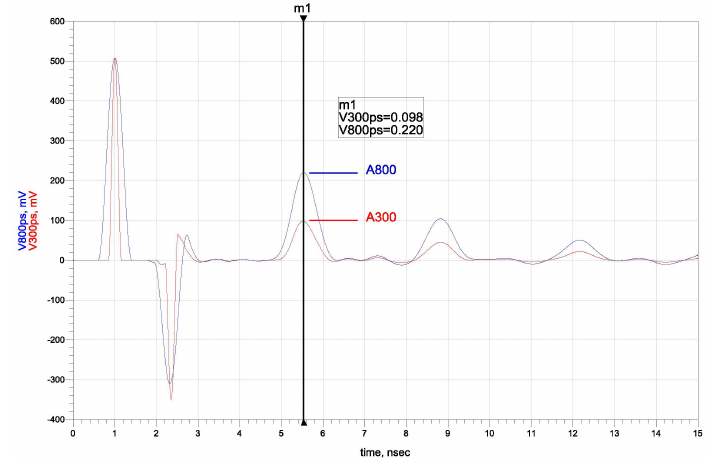
Figure 7. The time-domain results for needle pulses of 300 ps and 800 ps width for simulated Debye material characterized by ε 8 = 5, ε s = 80, σ = 50 µ S ¨ m ´ 1 , τ = 8 ps.